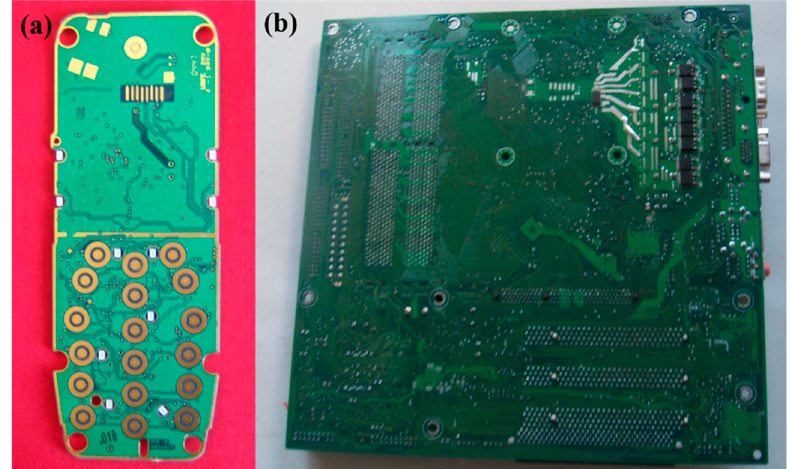
Figure 1. Printed circuit boards (PCBs): ( a ) Cell phone and ( b ) Computer. Table 1. Metals present in the printed circuit boards (PCBs) of computers and cell phones. Metals (wt Type of PCBs